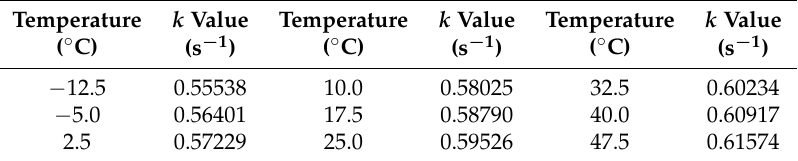
Table 2. Variation of k according to